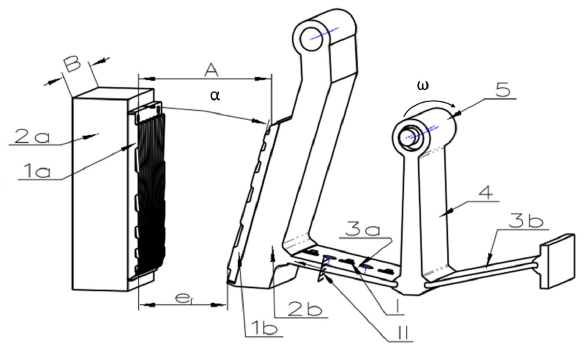
Figure 10: Scheme of the model jaw crusher: 1a, 1b – crushing plates, 2a – fixed jaw, 2b – moving jaw, 3a, 3b front end rear toggle, 4 – pitman, 5 – eccentric shaft, a, b – width and length of the inlet slot, I – force measurement system, II – moving jaw displacement measurement